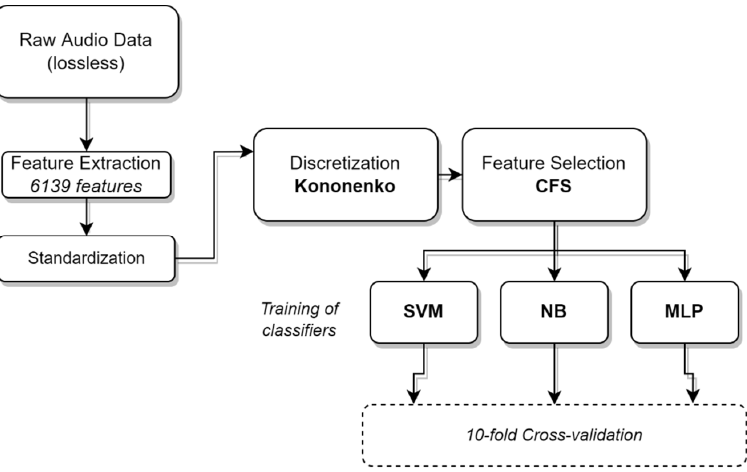
Figure 2. Flowchart for the SER Machine Learning framework.